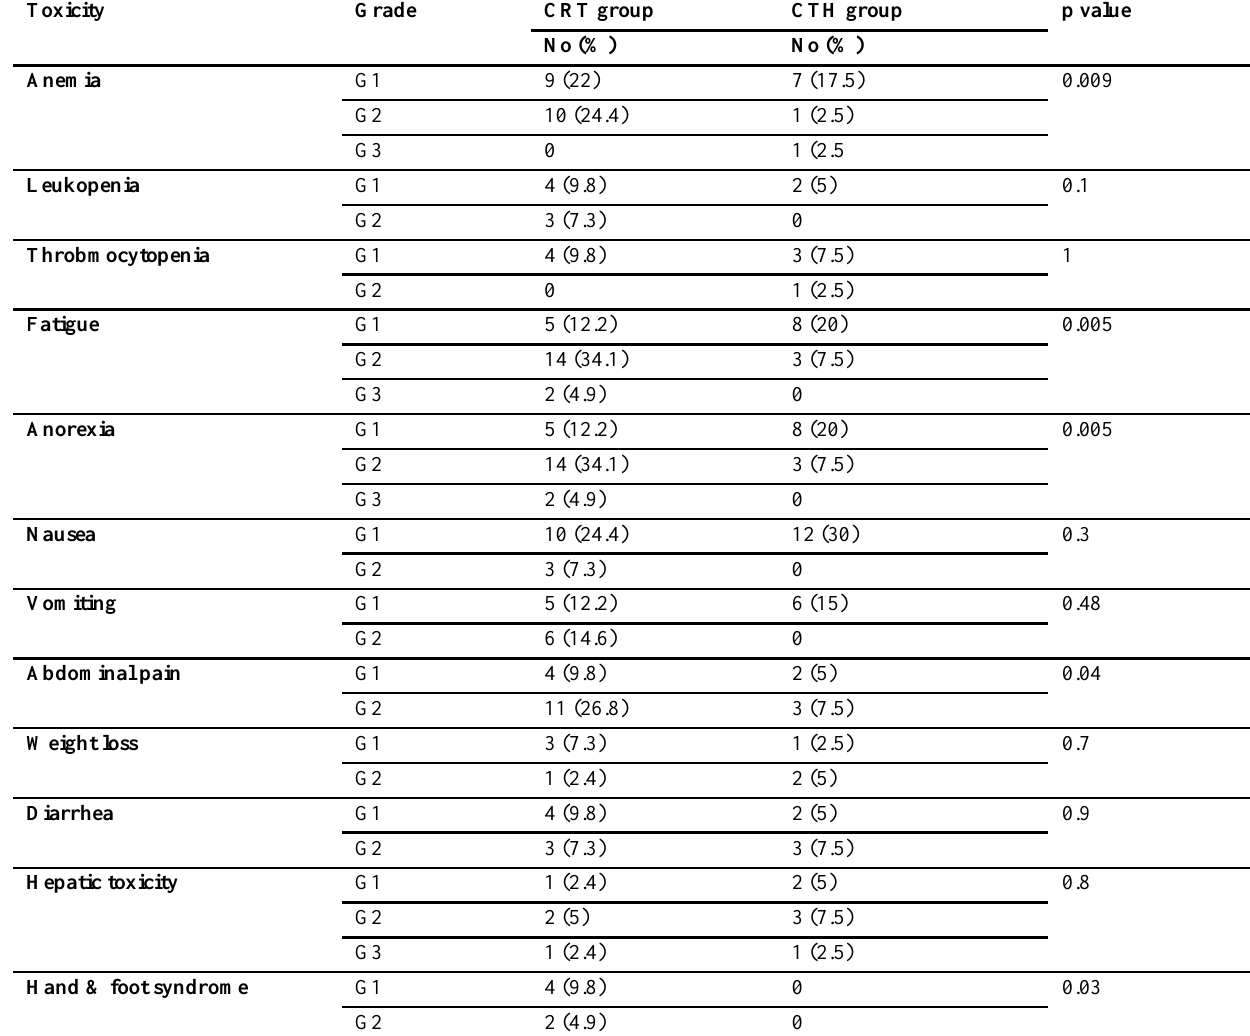
Table 3: Acute treatment toxicities in the study groups Toxicity Grade CRT group CTH group p value No (%) No (%) Anemia G1 9 (22) 7 (17.5) 0.009 G2 10 (24.4) G3 0 1 (2.5